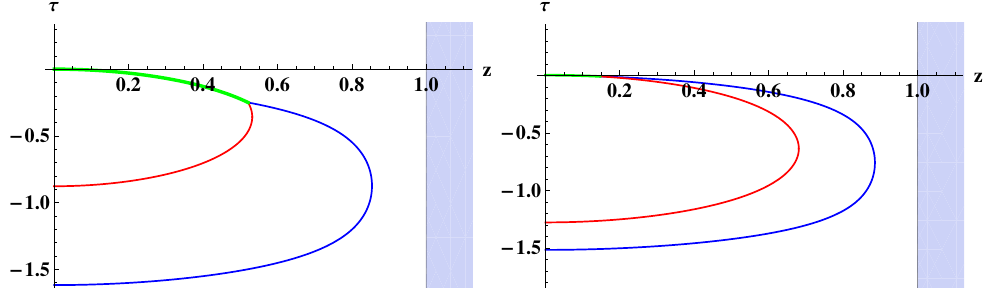
Figure 4 . a) Non-symmetric configuration for ∆ 1 = 50 , ∆ 2 = 50 and ∆ 3 = 90 , with the operator O ∆ placed between O ∆ and O ∆ . b) ∆ 1 = 50 , ∆ 2 = 50 and ∆ 3 = 99 . 9 . [Same color notation as 1 2 3 in figure